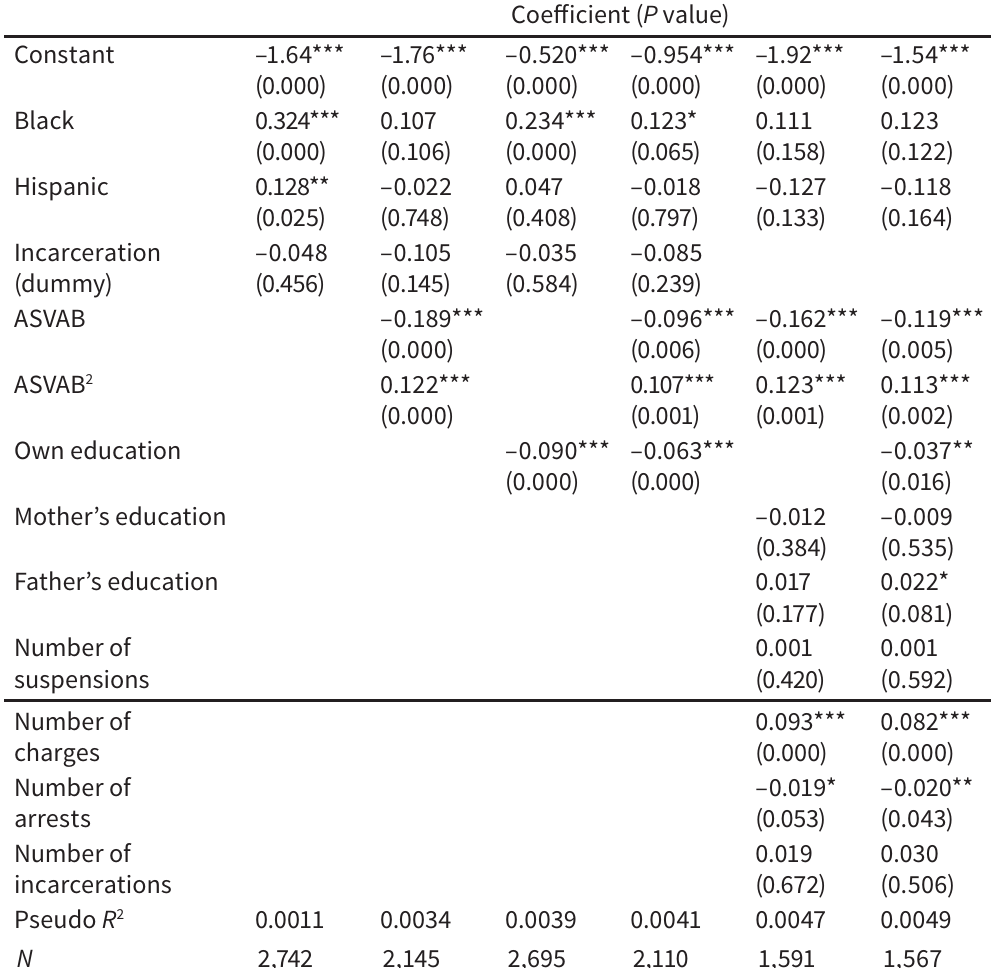
Negative binomial regression, weeks not working,